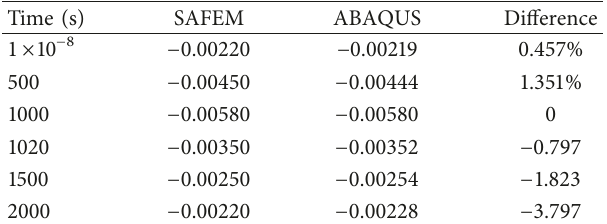
Table 4: Comparison between ABAQUS and SAFEM regarding the determined vertical strains (